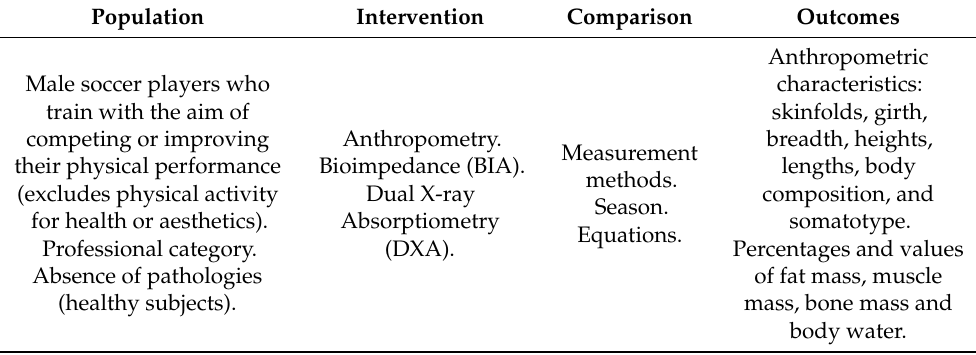
Table 1. The inclusion criteria applied in the study followed the Population, Intervention, Compari- son, and Outcomes (PICO)